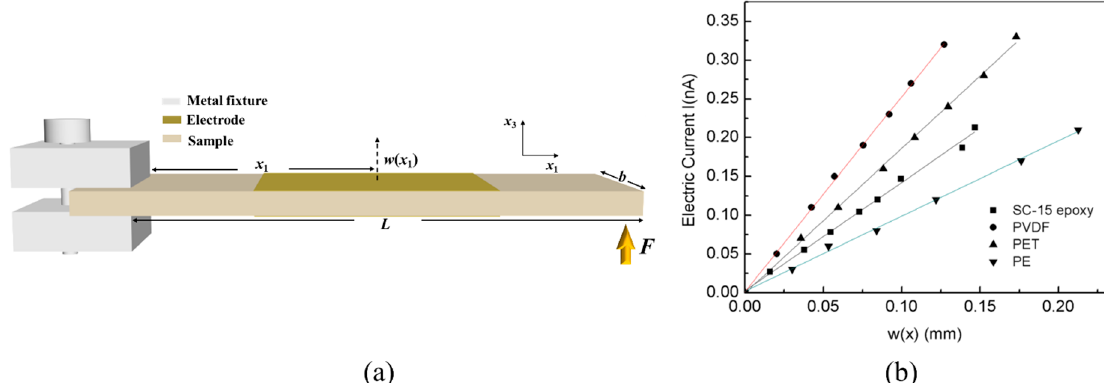
Figure 1. ( a ) Schematic of the cantilever bending method used to apply a strain gradient. The dotted arrow represents the displacement w ( x 1 ) of point x 1 when applying F to the free end of the beam. ( b ) The relationship between the electric current induced by the flexoelectric effect and the displacement of a specific point on the polymer beam. Reprinted with permission from [21]. Copyright 2012 AIP Publishing.